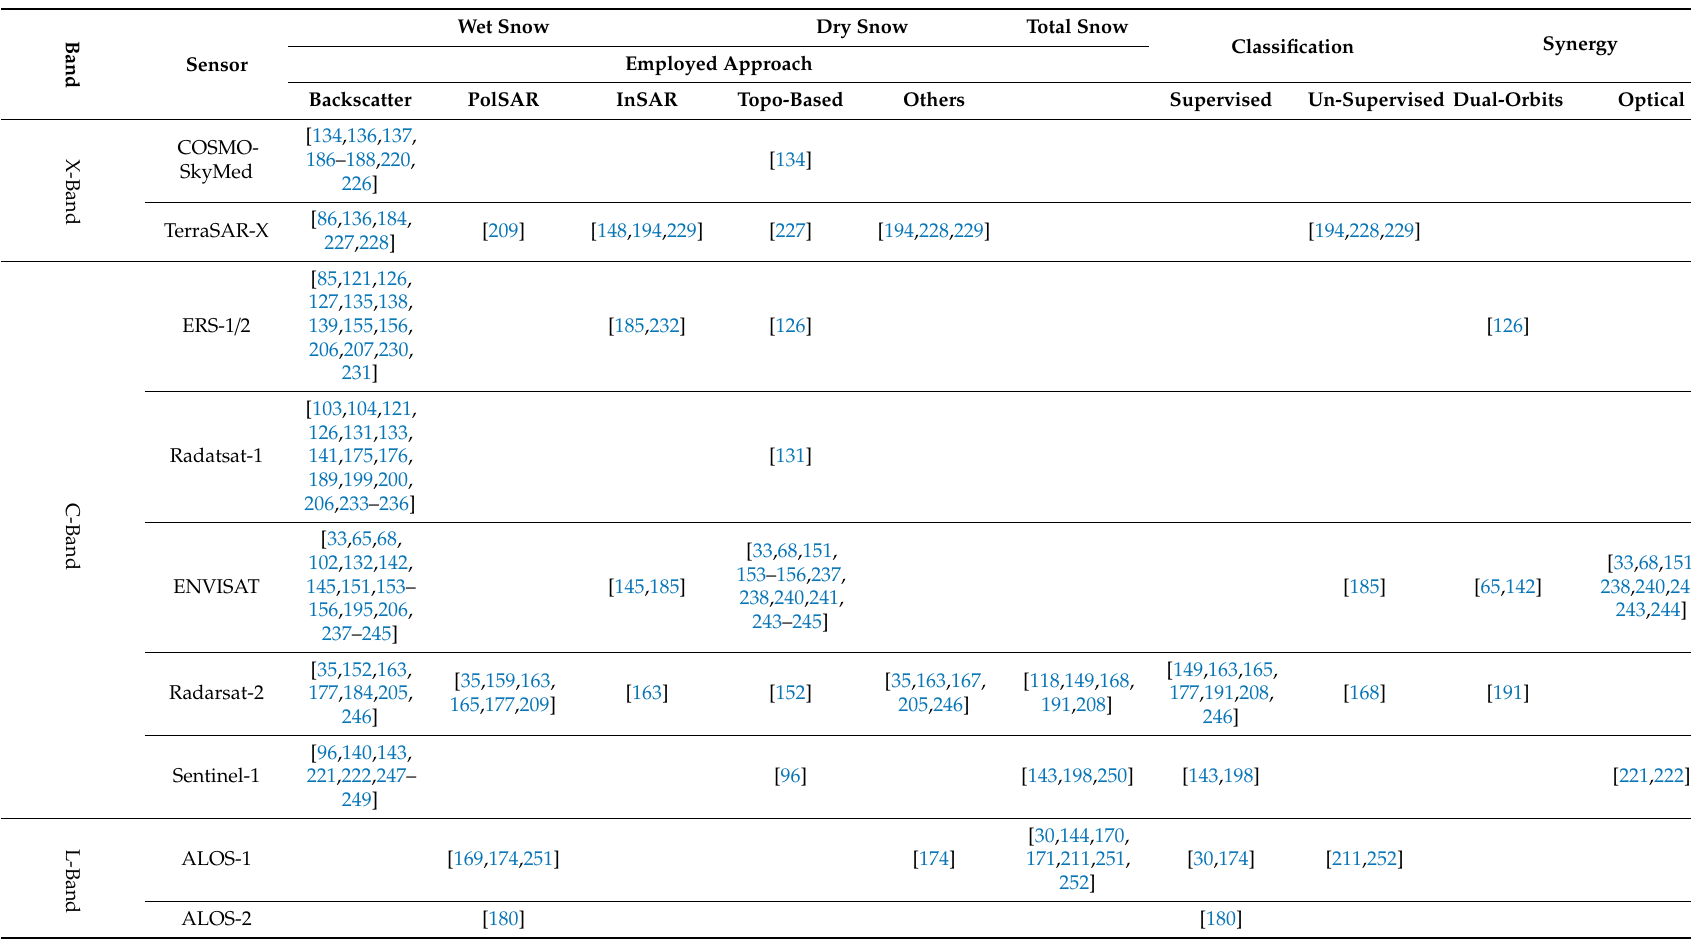
Classification Synergy